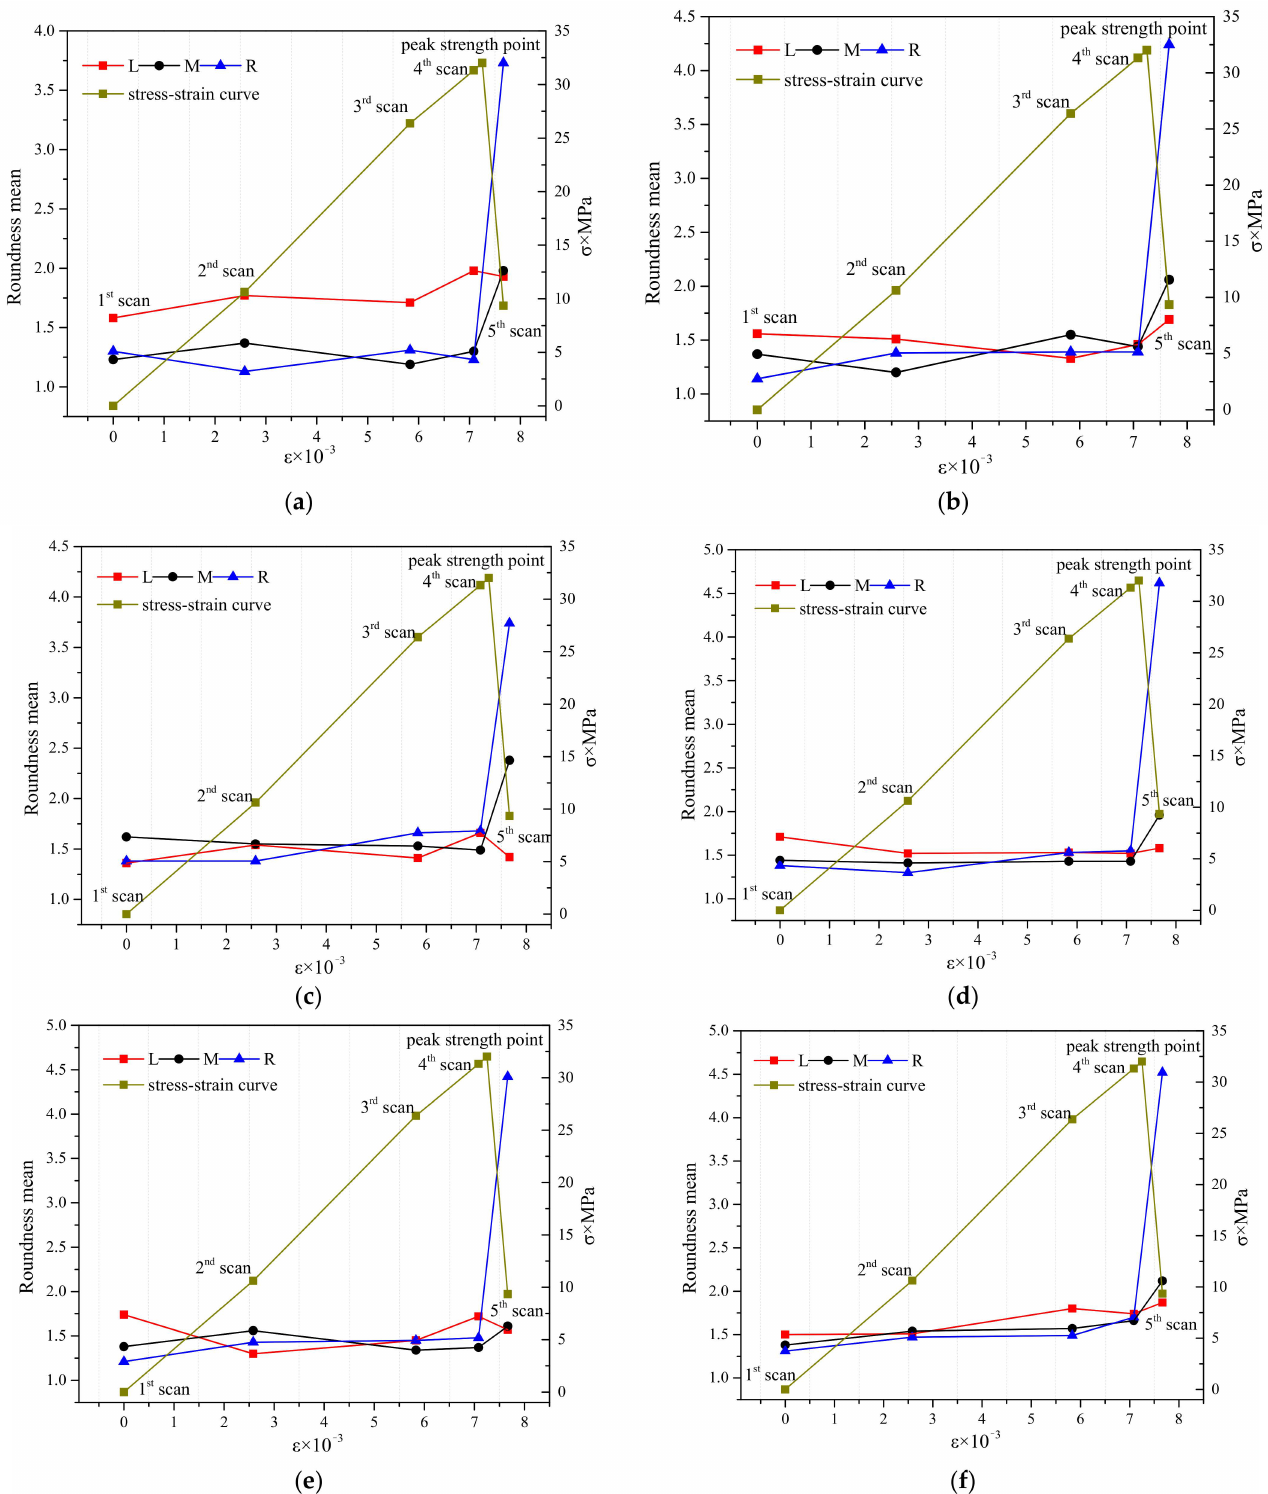
Figure 8. Roundness mean variation with loading in each area, ( a ) S120, ( b ) S130, ( c ) S140, ( d ) S150, ( e ) S160, ( f )